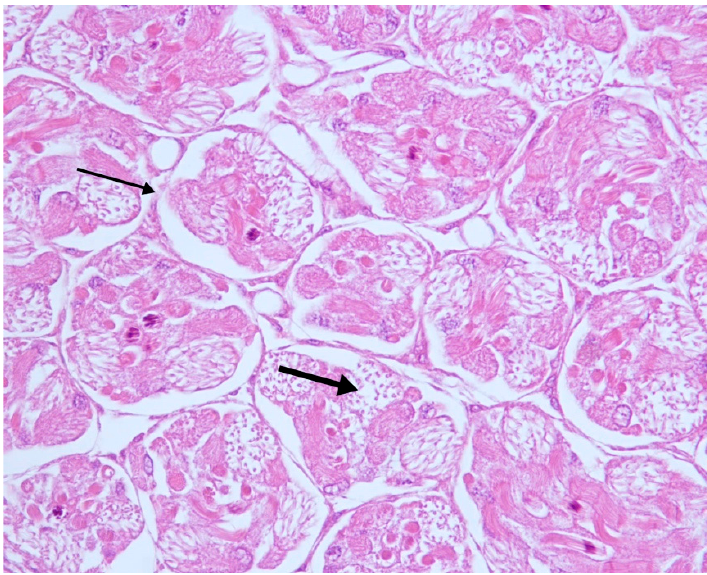
Figure 4. Testes. Altered seminiferous tubules. Detachment of germ cells from the basal lamina (thin arrow); rupture of the membranes of spermatogonia (thick arrow). H—E 20×.